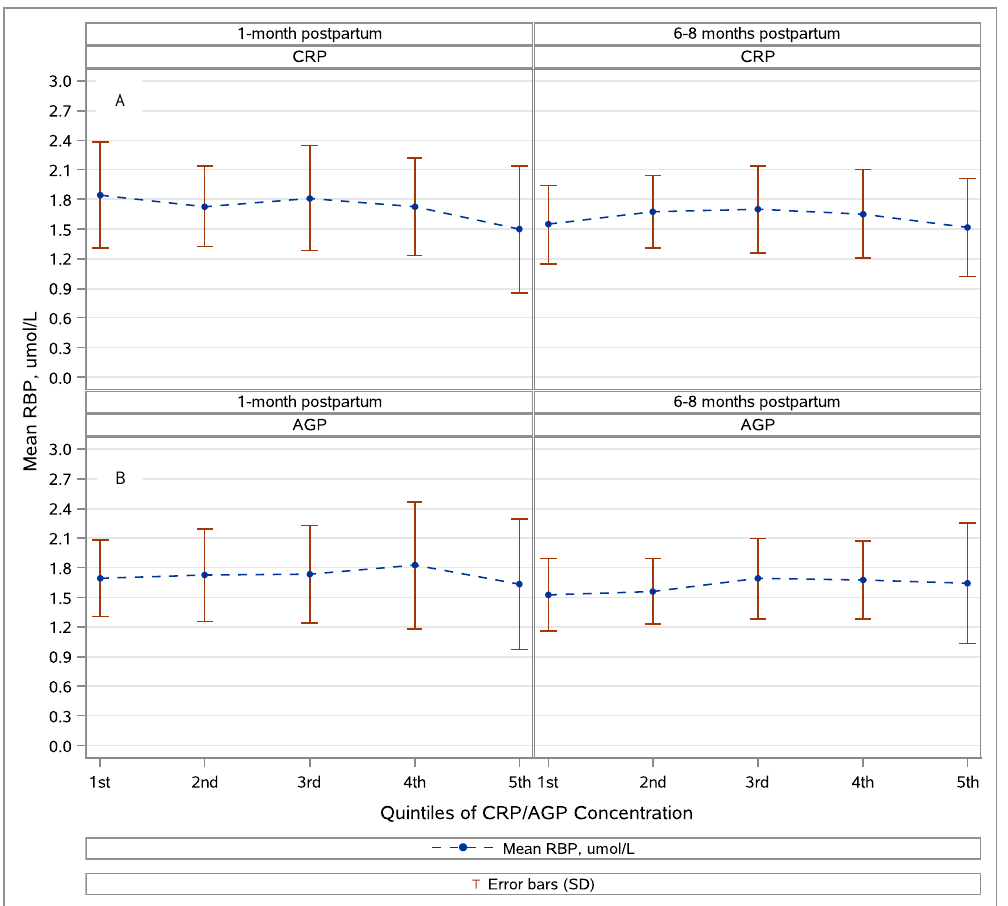
Figure 2. The mean maternal retinol binding protein (RBP) by quintiles of the alpha(1)-acid glycoprotein (AGP) and the C-reactive protein (CRP) by blood draw. Panel ( A ) shows results for the first blood draw (~1 month postpartum) and panel ( B ) shows results for the second blood draw (~6 months postpartum). The mean RBP was not significantly different (Wilcoxon signed rank test, p > 0.05) by CRP or AGP quintile for mothers at either blood draw.